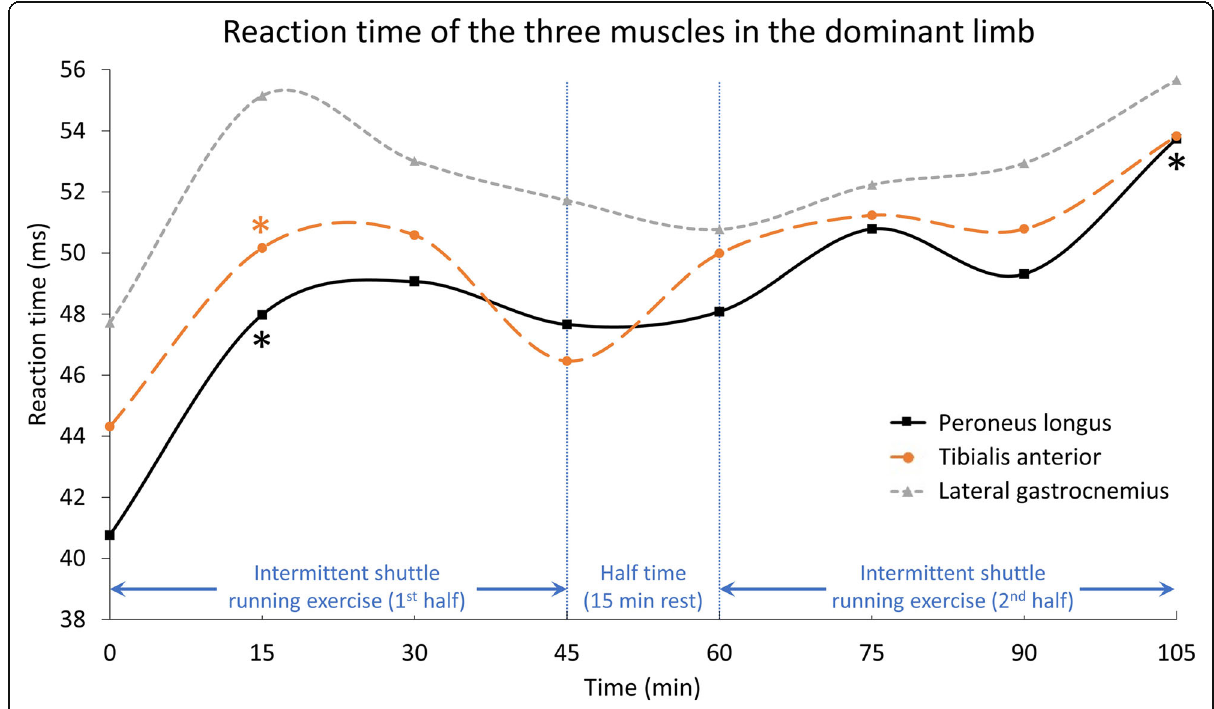
Fig. 3 Reaction time of the three muscles in the dominant